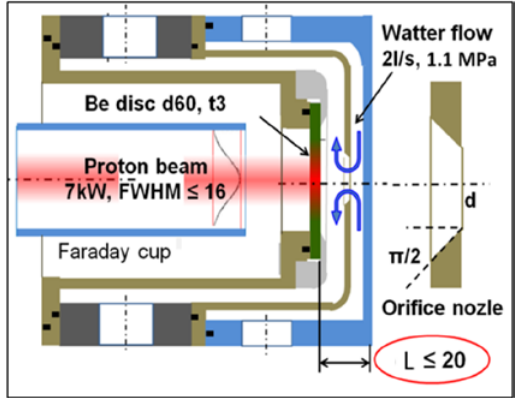
Fig. 2. Schematic arrangement of target chamber with Be disc, Faraday cup and orifice nozzle for ANSYS simulation. Dimensions are in mm.